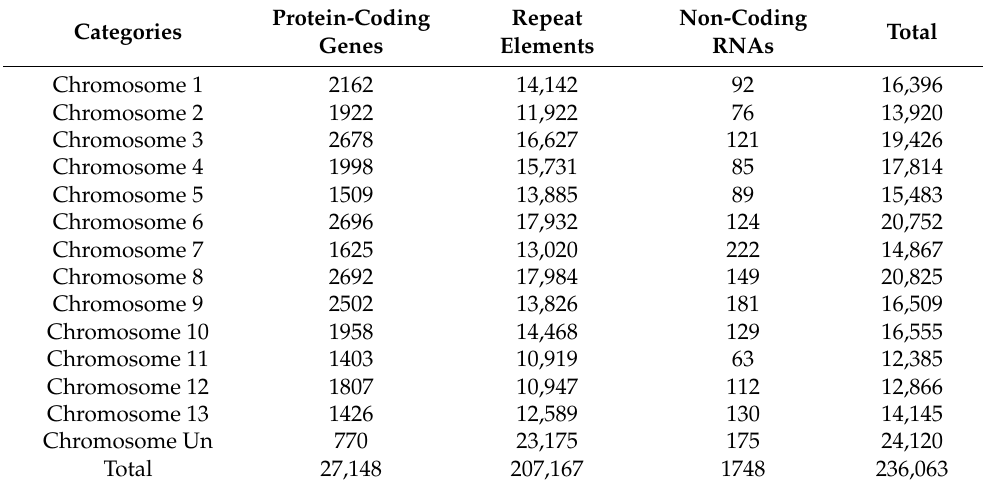
Table 1. Statistics of genome components of Sesamum indicum genome v2.0.